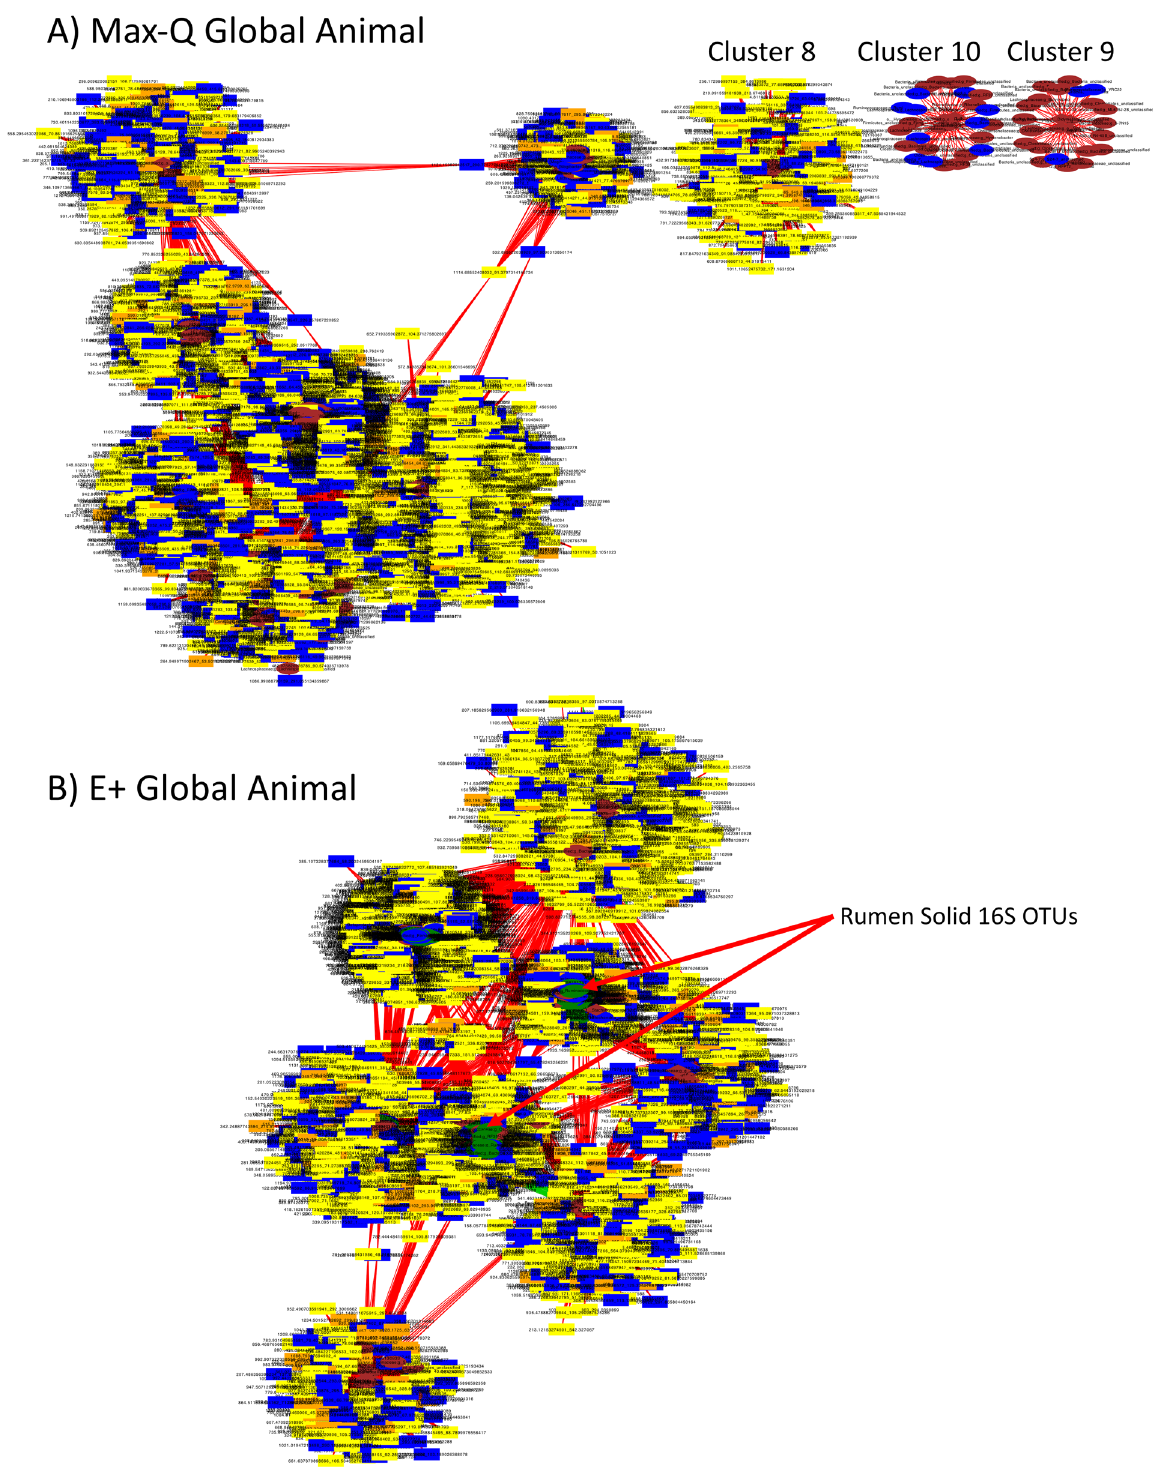
Figure 8. Global whole animal integrative interactomics networks of the relationships between bacterial (oval) and fungal (diamond) OTUs and metabolites (rectangle) in the rumen solid (green), rumen liquid (blue), plasma (orange), urine (yellow), and feces (brown) of either ( A ) non-toxic (Max-Q; n = 6) or ( B ) toxic (E+; n = 6) endophyte-infected tall fescue grazing beef steers. Green and red edges indicate positive and negative correlations,